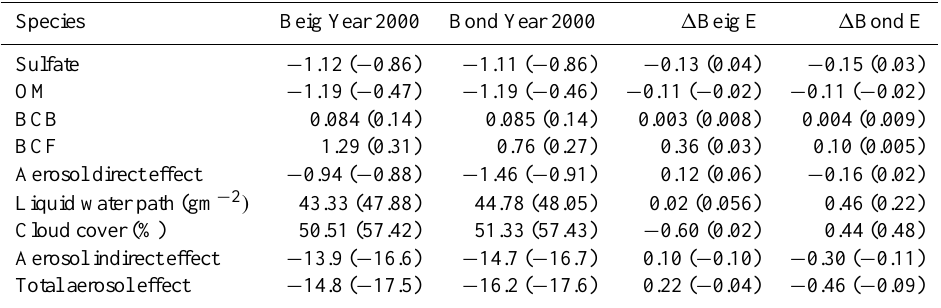
Table 3. Annual average instantaneous shortwave radiative forcings at the top of the atmosphere averaged over India (4 ◦ –40 ◦ N and 65 ◦ – 105 ◦ E) for the various simulations. OM refers to organic matter, BCB to black carbon from biomass sources and BCF to black carbon from fossil/bio-fuel sources. Global values are given in parenthesis since emission changes from 1990 to 2000 occur globally. Also included are values for the aerosol indirect effect (estimated from changes to the net (shortwave + longwave) cloud forcing), cloud liquid water path and cloud cover. All units are in Wm − 2 unless otherwise indicated. Simulations represented include those with the Beig and Bond emissions for Year 2000 and changes (represented by 1 ) from differences in emissions from 1990 to 2000 (E).